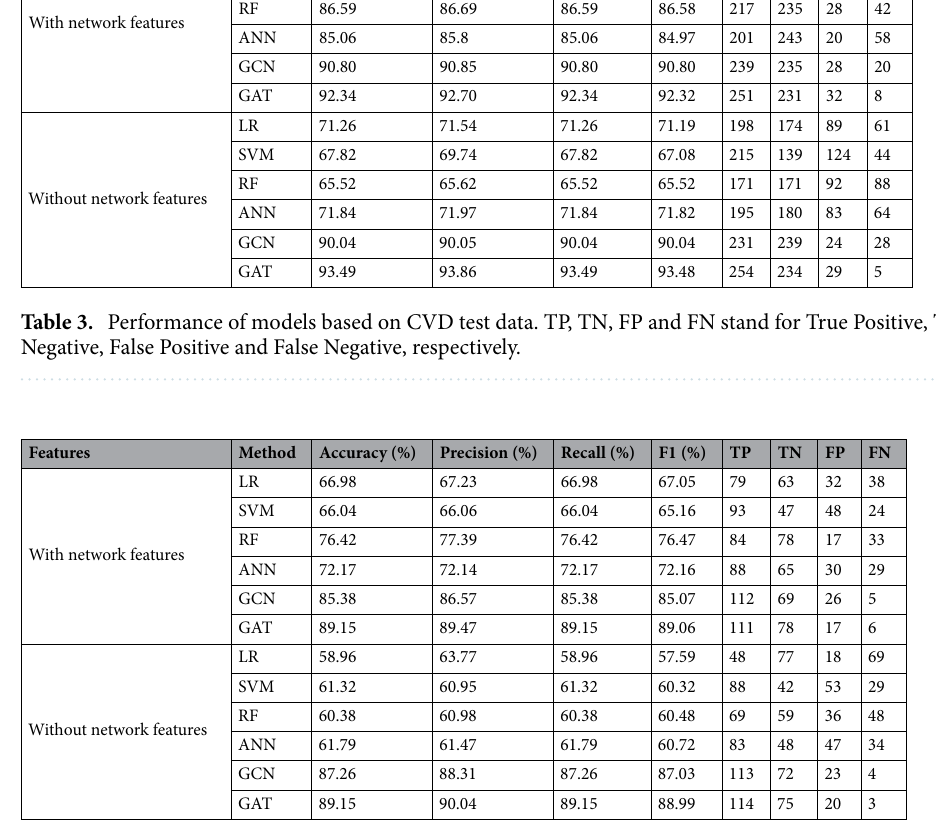
Table 4. Performance of models based on CPD test data. TP, TN, FP and FN stand for True Positive, True Negative, False Positive and False Negative, respectively.